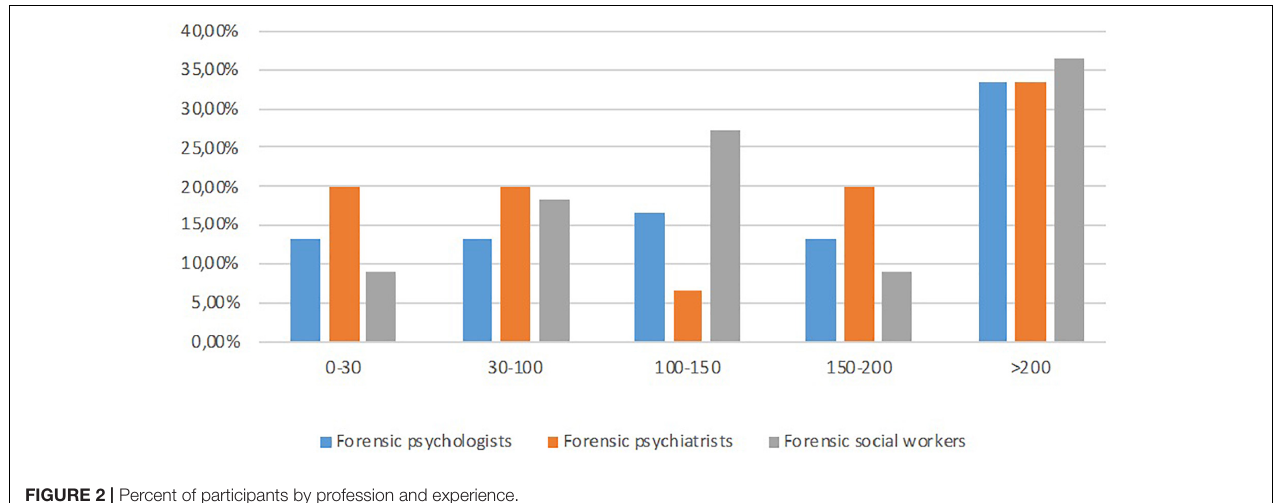
FIGURE 2 | Percent of participants by profession and experience. TABLE 2 | Mean values (and standard deviations) of number of information sources in each case vignette by profession and experience.